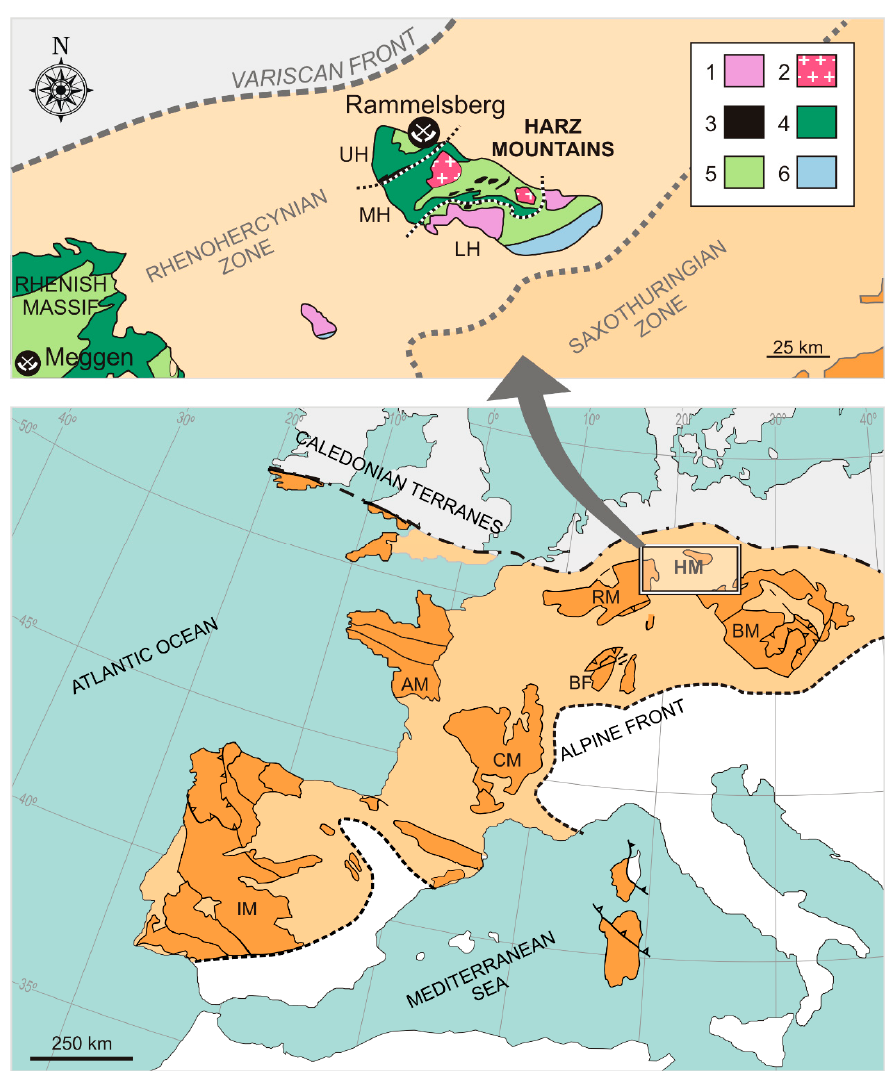
Figure 1. Sketch of the European Varican Belt with indication of the major massifs and geological map of the Harz Mountains showing the location of the Rammelsberg and Meggen massive sulfides. Abbreviations: AM, Armorican Massif; BF, Black Forest; BM, Bohemian Massif; CM, Central Massif; HM, Harz Mountains; IM, Iberian Massif; RM, Rhenish Massif; LH, Lower Harz; MH, Middle Harz; UH, Upper Harz. Legend: 1, Permian deposits; 2, Permian granitic rocks; 3, Devonian–Mississippian basic rocks; 4, Carboniferous shales and graywackes; 5, Middle Devonian sand-banded and calcareous shales; 6, pre-Devonian sedimentary